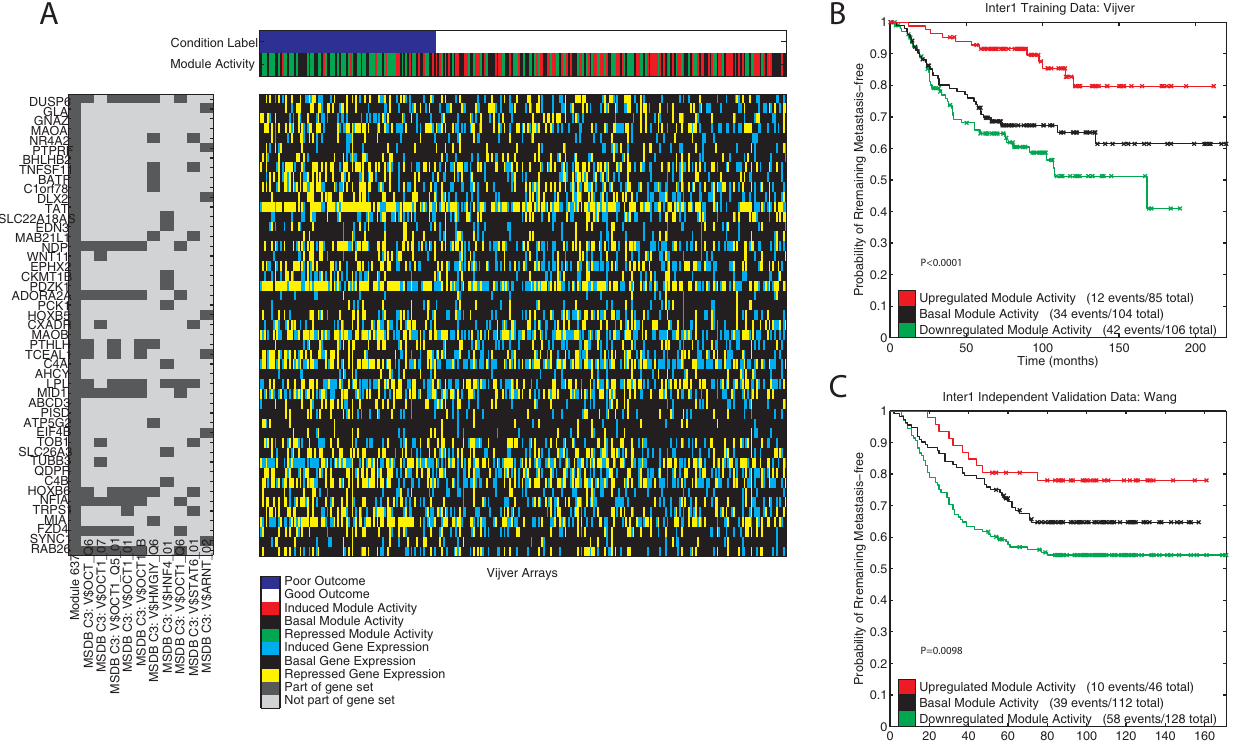
Figure 9. An Oct1 related module. A) Module activity data of an OCT1 transcription factor related module (Module group 4 in Figure 7) that was extracted from the Vijver [21] data (Inter1, Table 1). The top heatmap shows the binary condition label, and the discrete module activity data (rows), for all the Vijver arrays (columns) [4]. Arrays are ordered according to the metastasis free survival time. The heatmap in the middle shows the discrete gene expression data for the 47 genes (rows) in the module. On the left, a binary heatmap shows the 47 genes, along with the gene sets that show the most significant overlap with this module. The gene sets are ranked based on their p-value for the overlap with the module (hypergeometric distribution), we show the top 10 gene sets (p-values ranging from 10 2 13 to 10 2 7 , all significant at p , 0.05 after Bonferroni correction). On the right, two Kaplan-Meier curves indicate the predictive power of this module when arrays with the same module activity are grouped. B) The Kaplan-Meier curves for the three groups defined by the activity of this module on the Vijver [21] data (Inter1 training, Table 1). C) The Kaplan-Meier curves for the three groups defined by the activity of this module on the independent [3] data (Inter1 test data, Table 1). The legend indicates the three groups and lists the number of events and total number within the groups. P-values correspond to the logrank test.